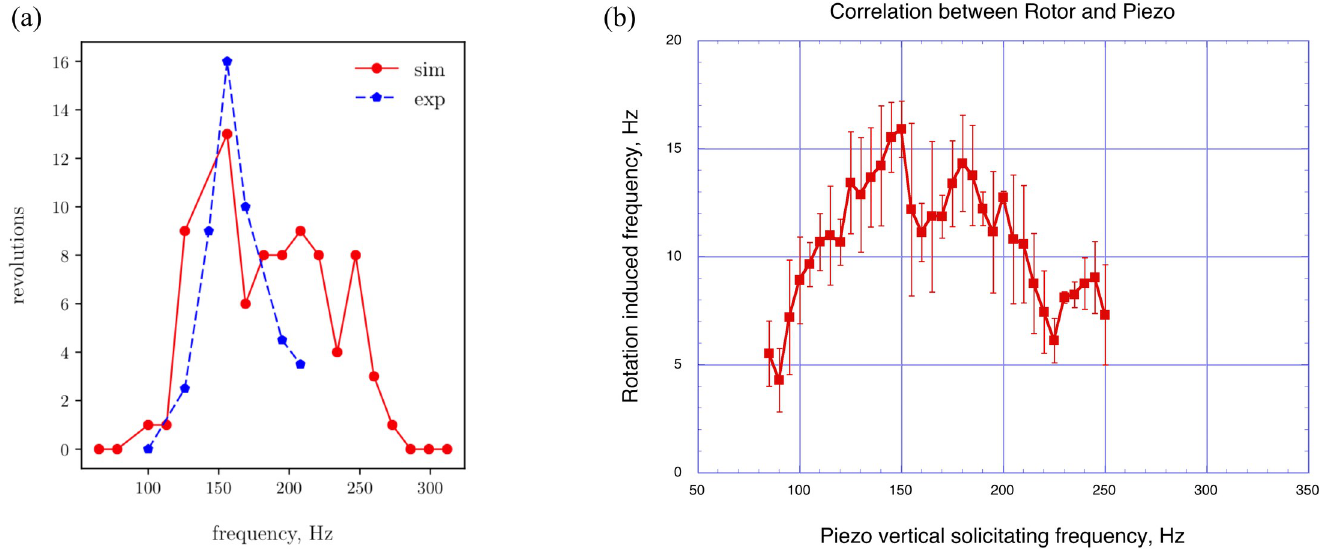
Fig 6. Experimental results for the piezo vibration source and comparison with simulations. (a ) Comparison between some experimental and simulated data for a Notched Stick with a plastic rotor on a free moving microbearing mounted on a piezo vibratory device. Revolution frequency of the propeller as a function of excitation frequency. Each point corresponds to a single run of the experiment or the numerical simulation. The range of excitation frequencies at which the propeller rotates is similar for experimental and simulated tests. ( b) Experimental data for a Notched Stick with a plastic rotor on a free moving microbearing mounted on a piezo vibratory device. Revolution frequency of the propeller as a function of excitation frequency in a larger interval than in Fig 6A. Repeated experiments allow to estimate the standard deviation of rotation frequency; the error on the imposed piezo frequency is negligible. The use of a piezo vibration source makes it possible a better control of the vibration plane. The data confirm the frequency peak at about 156 Hz and show a qualitative agreement with the simulated results of Fig 6A. Discrepancies in the experimental results of Fig 6A and 6B are probably due to the circumstance that, for technical reasons, between the two sets of measurements the apparatus had to be dismounted and the restored again (re-use of the antivibrating table for other purposes). The unavoidable aging of wood and polyurethane components, induced by the many operations carried out on the device, may also have played a minor role.